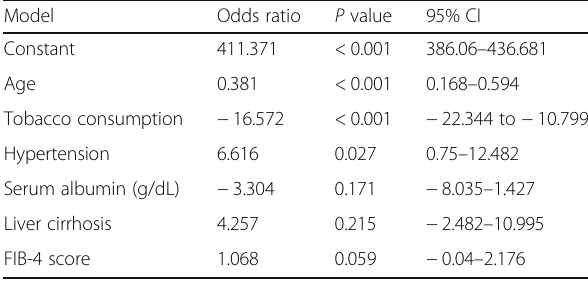
Table 4 Multivariate analysis for factors associated with long